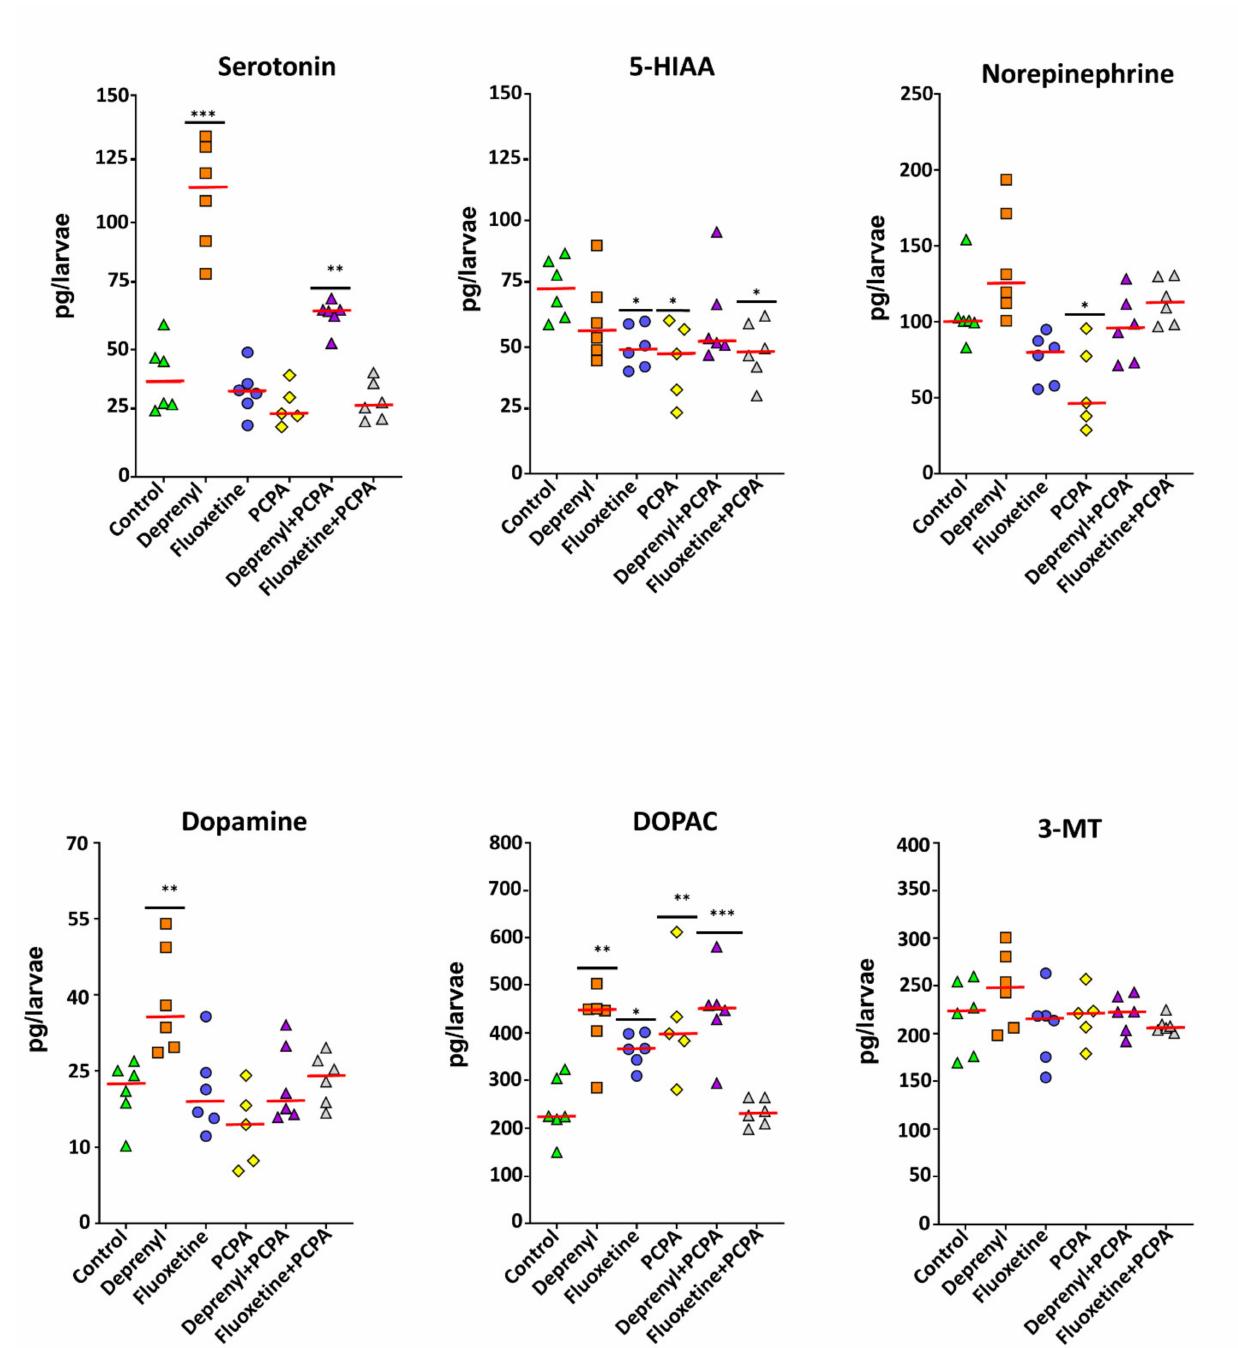
Figure 3. Monoaminergic neurotransmitter profiles of heads of zebrafish exposed to 5 µ M Deprenyl, 0.5 µ M Fluoxetine, 2.5 mM PCPA, and the combination of 2.5 mM PCPA with either Deprenyl 5 µ M or Fluoxetine 0.5 µ M. Data are reported as scatter plots with the median (red line) and n = 5–6 for all treatment groups. Significance was set to p < 0.05 and can be represented as * when p < 0.05; ** when p < 0.01 and *** when p < 0.001, one-way ANOVA with Dunnett’s multiple comparison